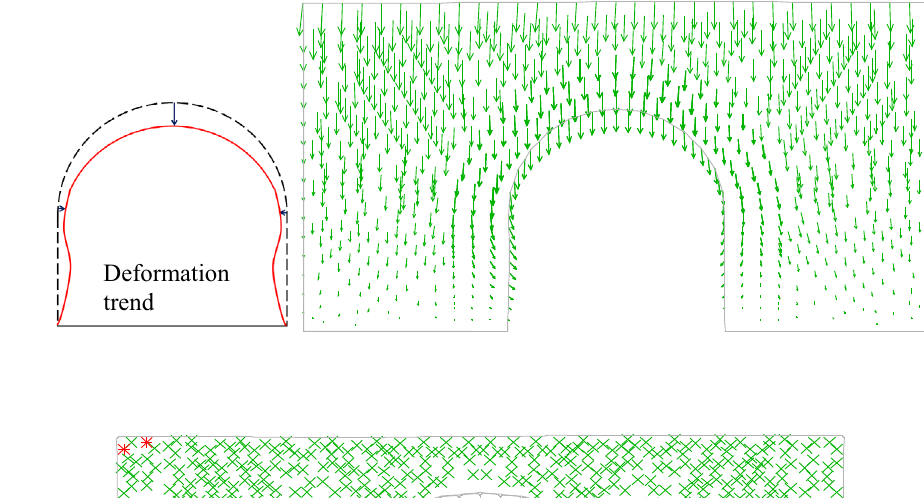
Fig. 5 Displacement vectors for UDEC A under uniform load ( H = 1075 mm)